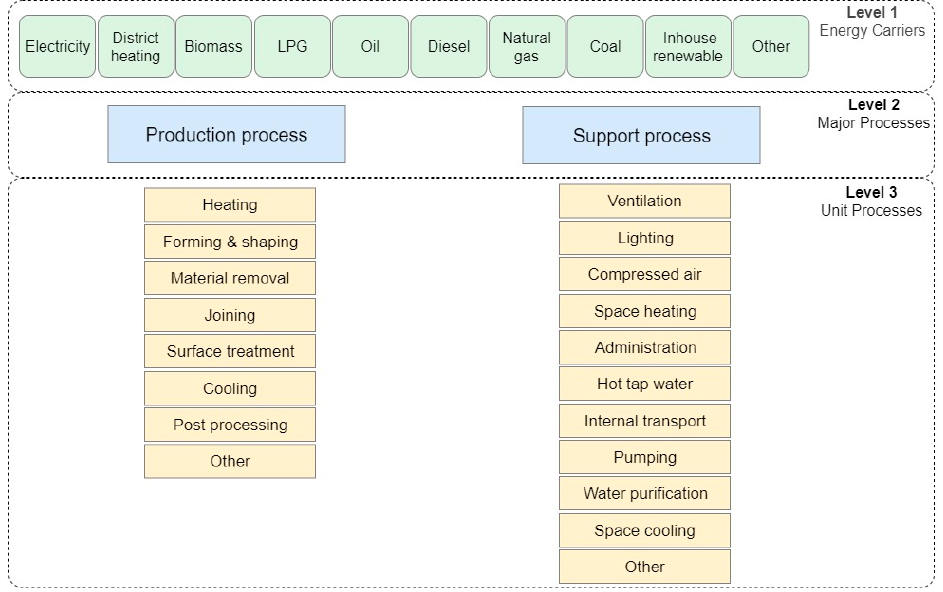
Figure 5. Tree showing Level 1, Level 2, and Level 3 categories of EEU taxonomy in the engineering industry.